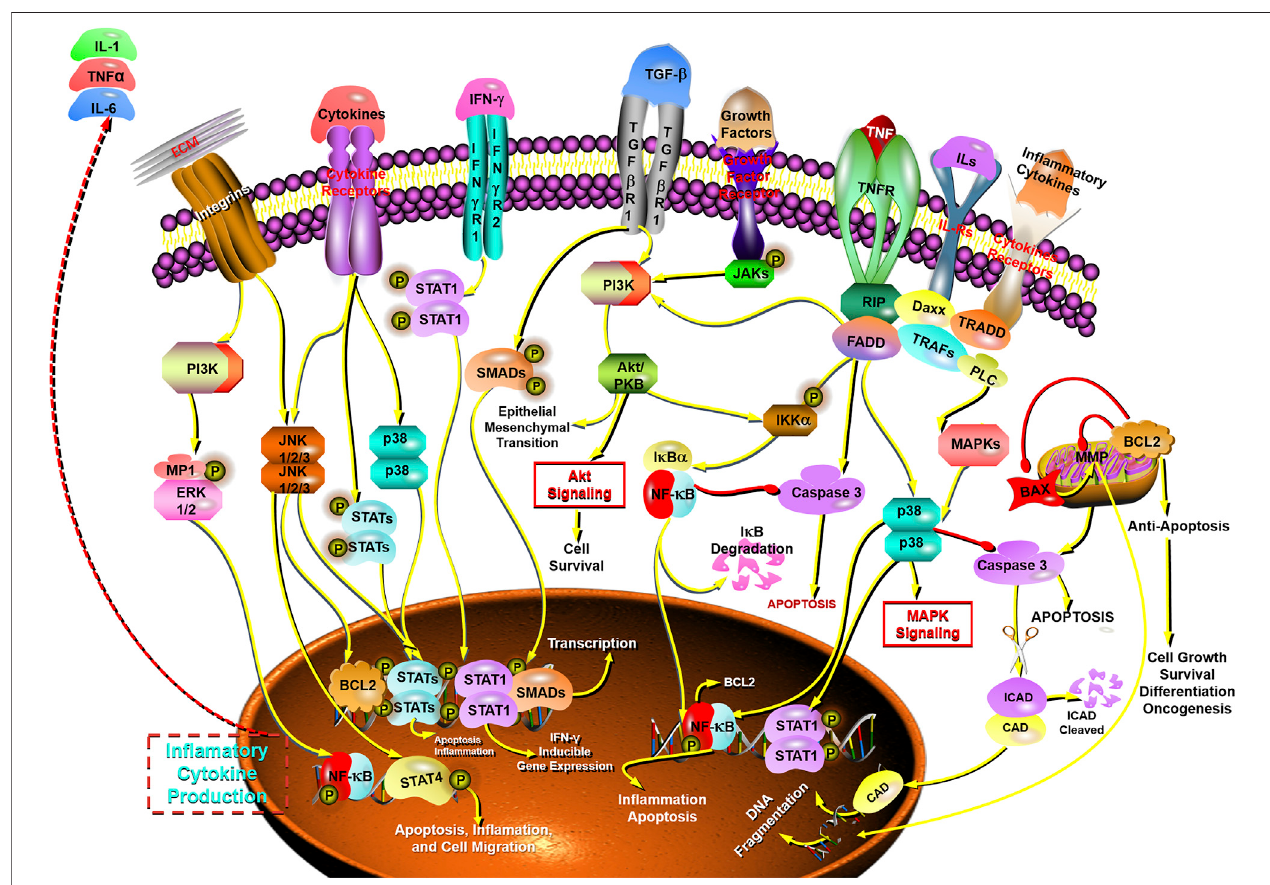
FIGURE 10 | The main related signaling pathways of BFC ’ s effect on respiratory diseases.